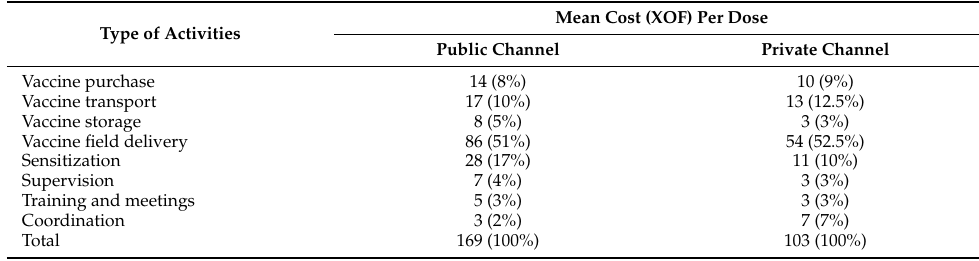
Table 1. PPR vaccination cost by